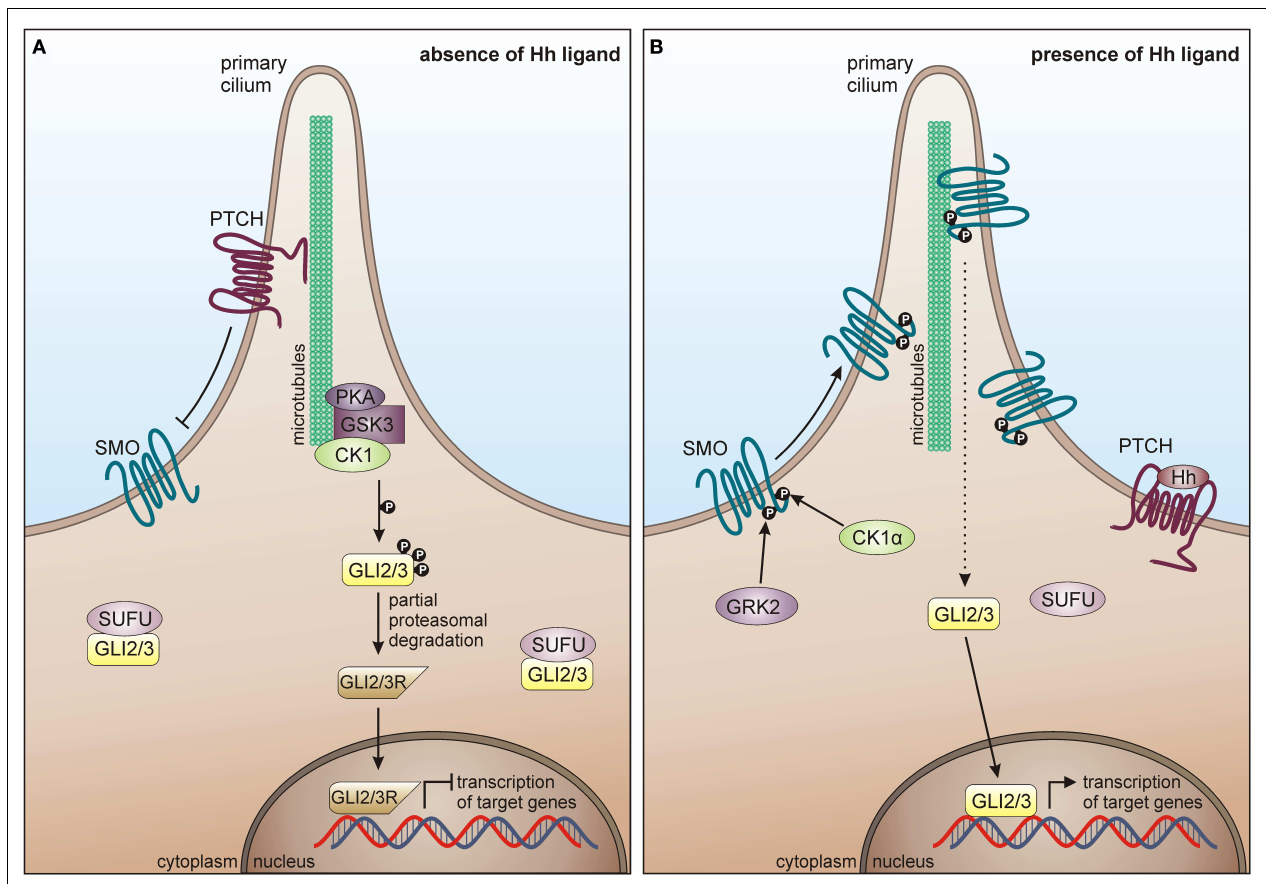
prevents GLI from activating Hh target genes, by binding it in the cytoplasm and the nucleus. (B) In response to Hh, SMO is activated by GRK2 and CK1 α -dependent phosphorylation and enters the primary cilium. Activated SMO orchestrates a signaling cascade, eventually resulting in the dissociation of the SUFU-GLI complex and the translocation of full-length GLI2/3 to the nucleus, where Hh target gene expression is